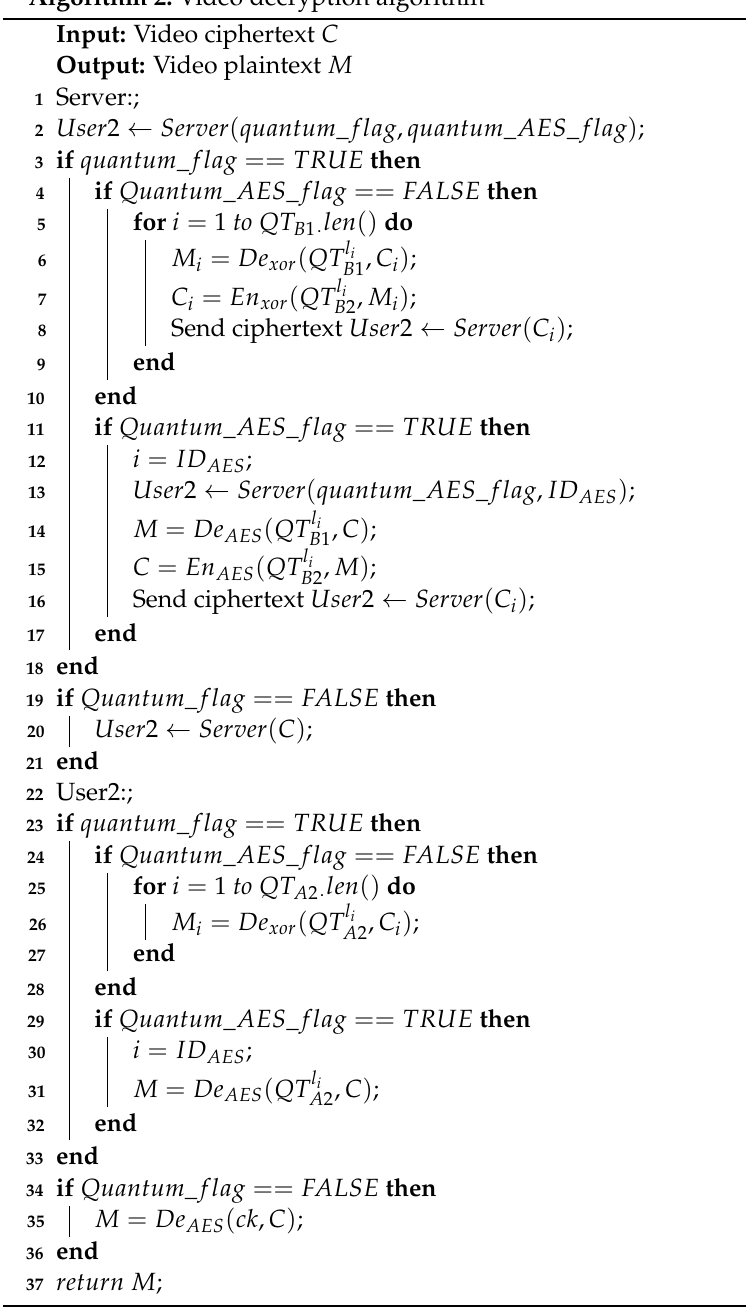
Algorithm 2: Video decryption